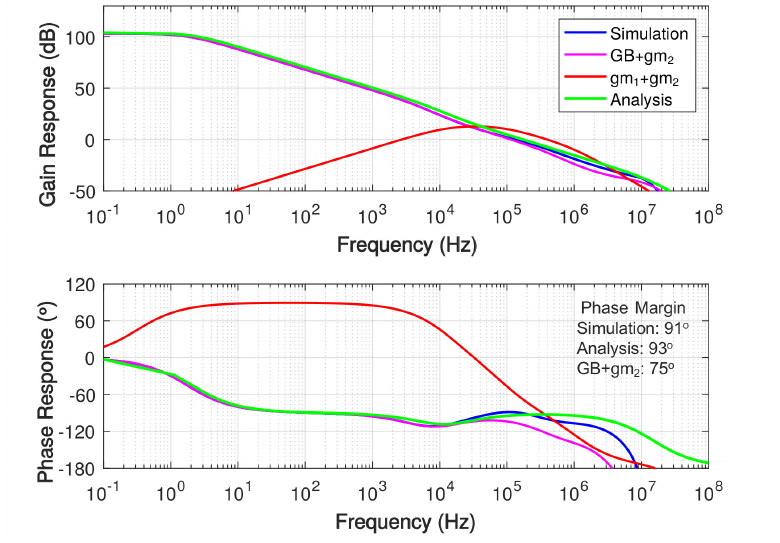
Figure 11. Simulated frequency response of the proposed amplifier with 2.5-nF load capacitance.